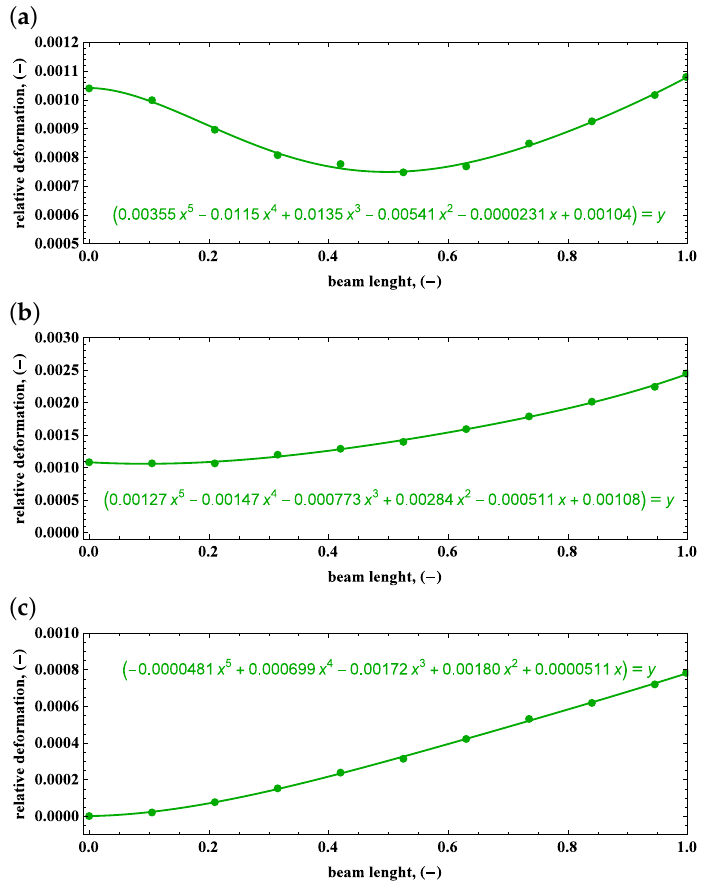
Figure 13. Beam deformations and their description by polynomials: ( a ) preset angle 45 ◦ and angular speed 50 rpm, ( b ) preset angle 45 ◦ and angular speed 100 rpm, ( c ) preset angle 90 ◦ and angular speed 50